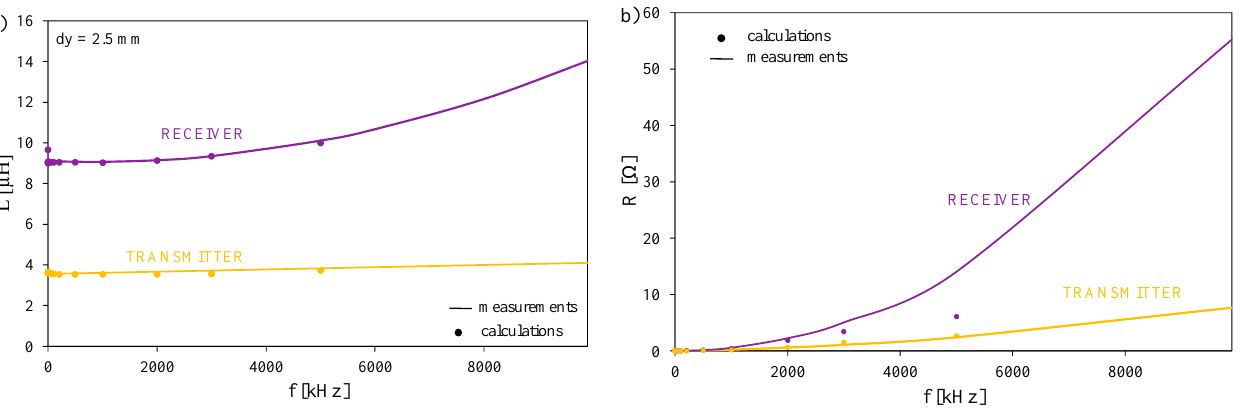
Figure 9. Dependence of inductance ( a ) and series resistance ( b ) of the transmitting and receiving coils on the frequency of the exciting